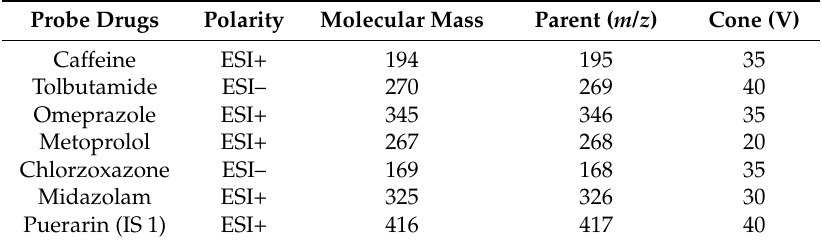
Table 8. Single-ion recording (SIR) transitions and cone voltages for the detection of CYP probe substrates and internal